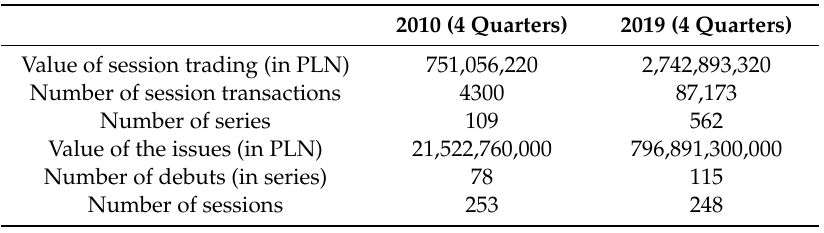
Table 2. Comparison of 2010 and 2019 on the Catalyst